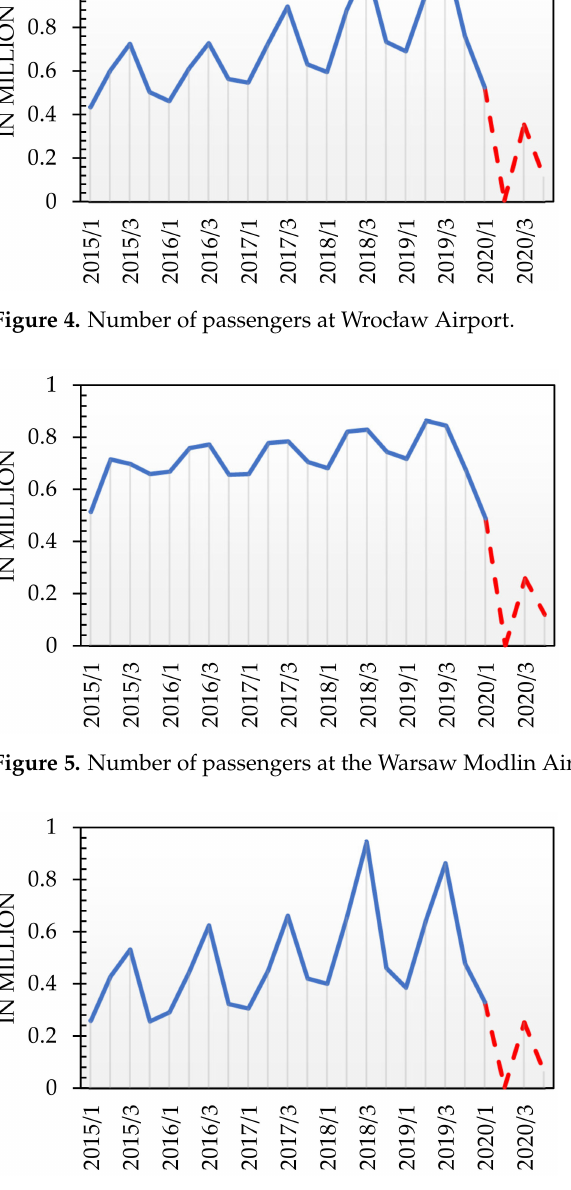
Figure 6. Number of passengers at Pozna´n Ławica